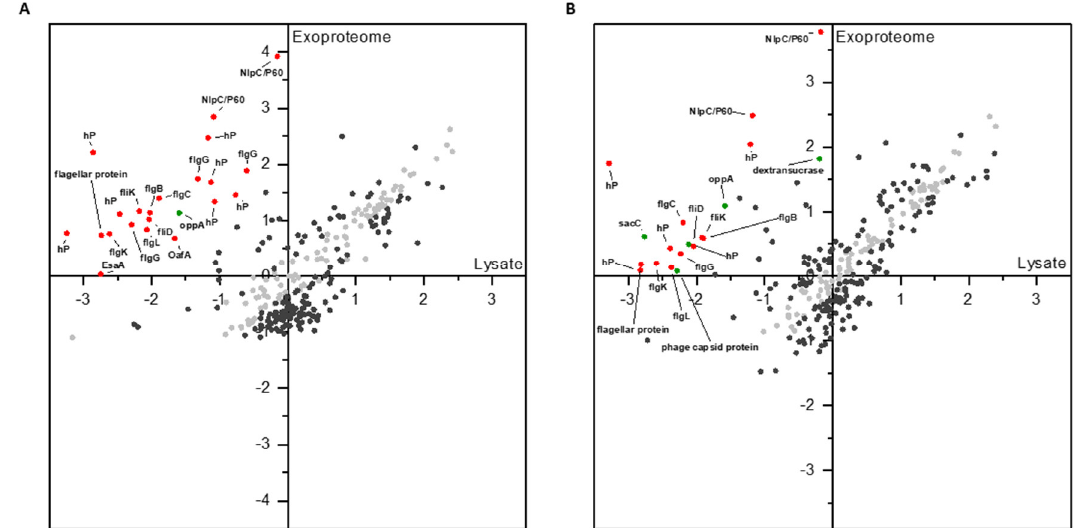
Figure 4. Comparison of abundances of proteins identified in cellular and extracellular proteomes in cultures incubated in glucose ( A ) and sucrose ( B ). All log 10- transformed iBAQ intensities were normalized by z-scoring. Light gray = proteins with similar relative abundance in cellular and extracellular proteomes; dark gray, red or green color = proteins of significantly di ff erent relative abundancy (FDR ≤ 0.01, S0 = 0.1); red and green color = proteins subjected for directed release with high confidence (z-score di ff erence exoproteome − cellular proteome ≥ 2.0); red color = proteins decreasingly released in the presence of sucrose; green color = proteins increasingly released in the presence of sucrose (Table S2). hP = hypothetical protein; flgB, flgC , flgG, flgK, fliD, fliK = flagellar proteins; oppA = peptide ABC transporter substrate-binding protein; OafA = acetyltransferase; EsaA = type VII secretion protein; sacC = putative